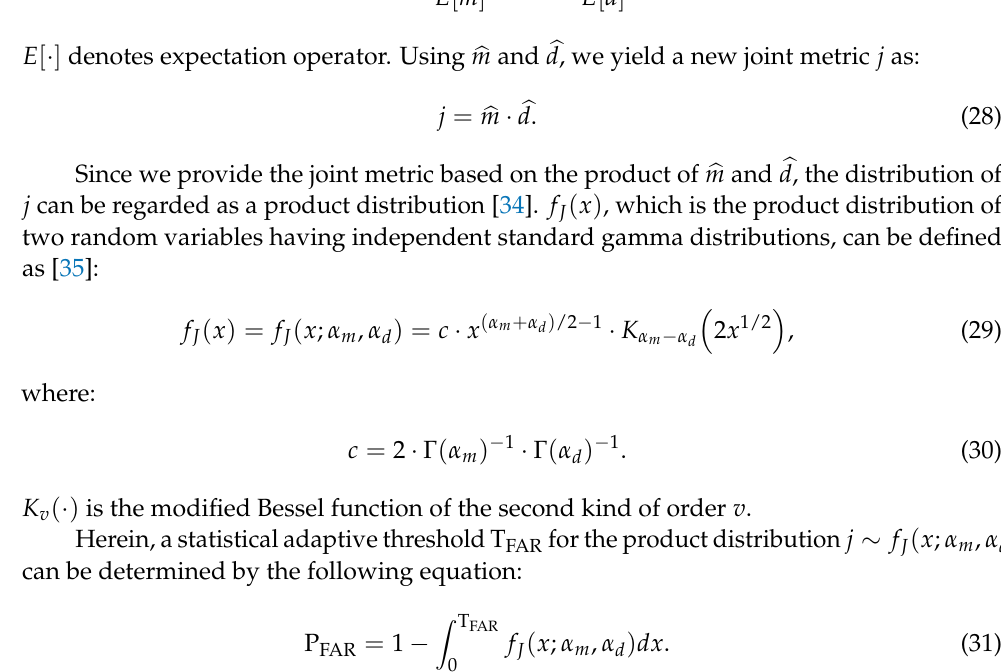
identical false alarm rate, P FAR = 10 − 3